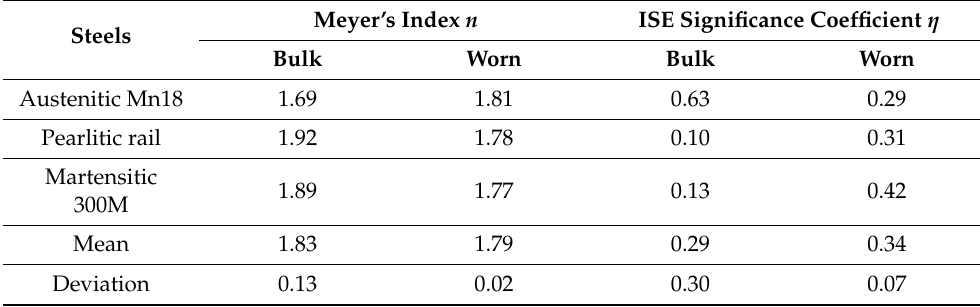
Table 7. Comparison of the ISE-related properties of different microstructure steels. Meyer’s Index n ISE Significance Coefficient η Steels Bulk Worn Bulk Worn Austenitic Mn18